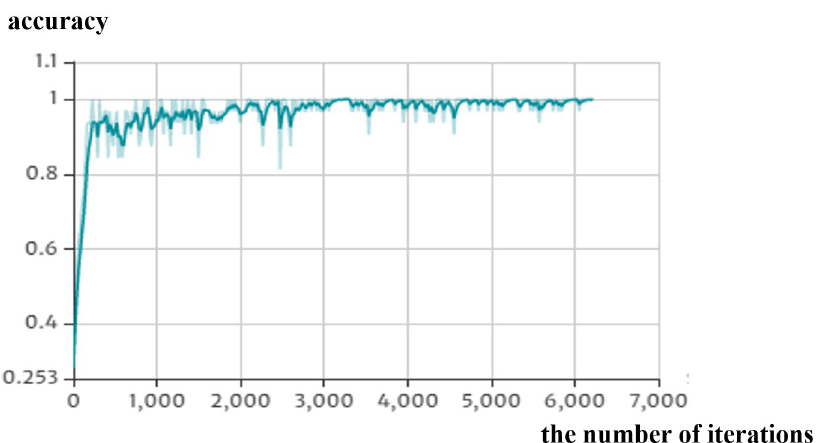
Fig 3. Classification accuracy versus the number of iterations in the training phase. (epoch = 20 and batch size = 32).